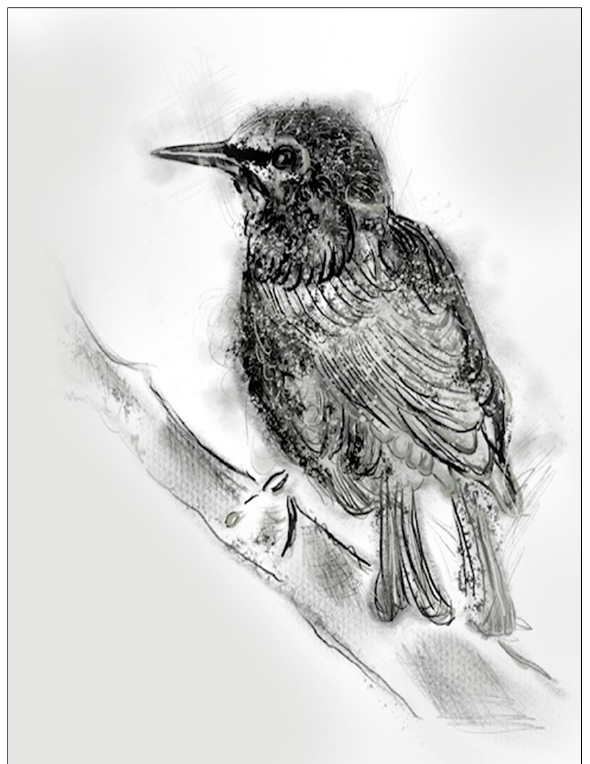
Figure 6. The starling is saddened when the children undergo the ‘Great Forgetting’ and refers to Mary Poppins as the ‘Great Exception’.